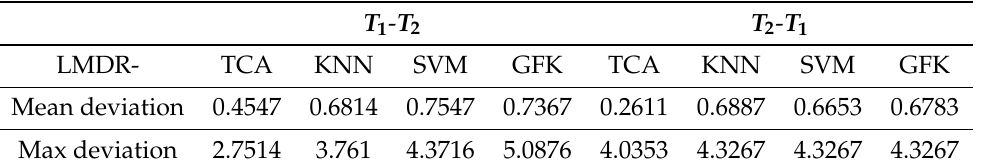
Table 2. Mean and maximum localization deviations among the different